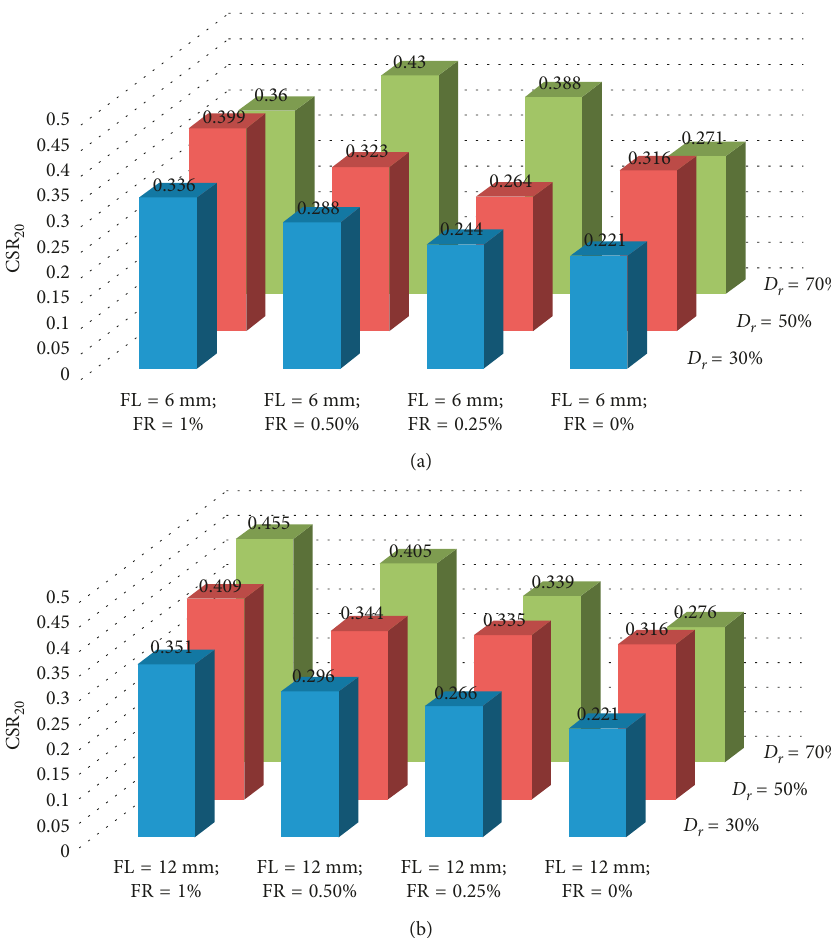
Figure 8: Cyclic stress ratio (CSR) values corresponding to N